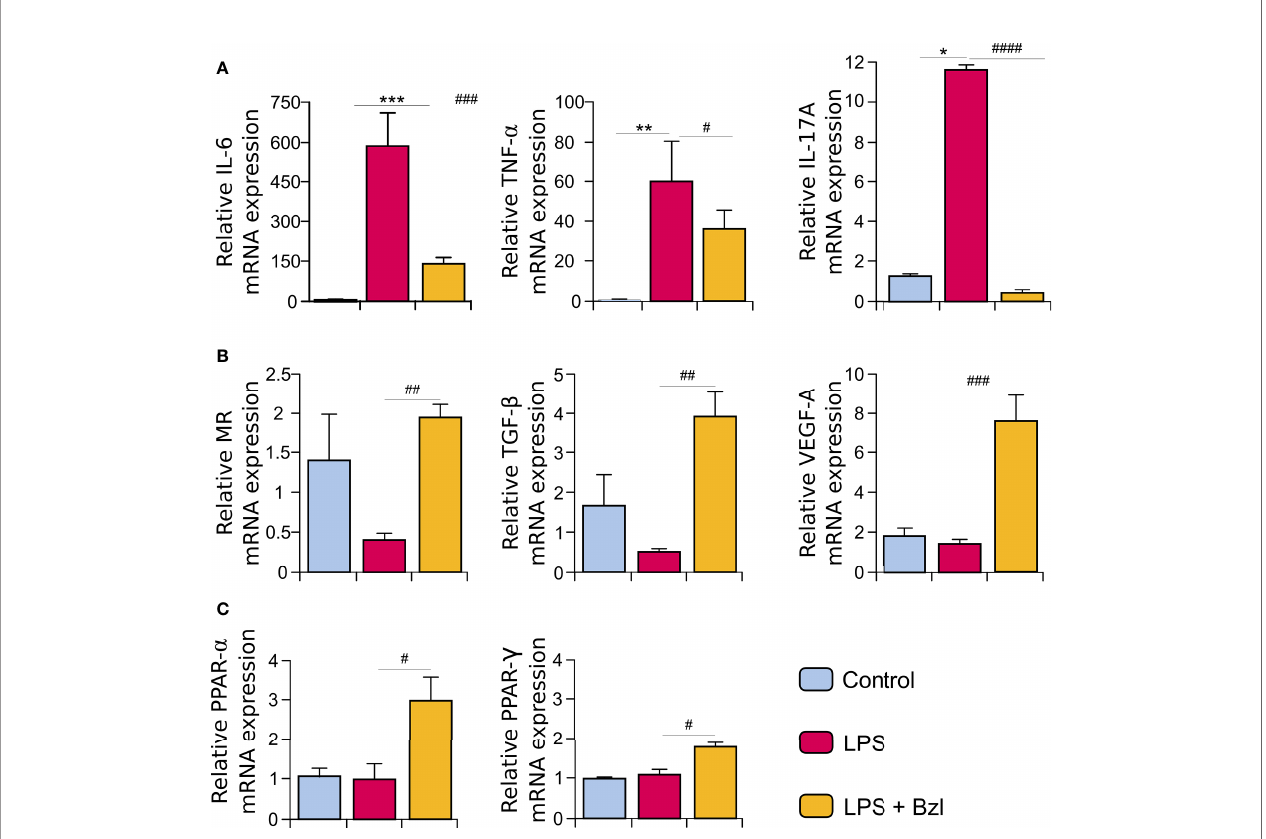
FIGURE 5 | RAW 264.7 macrophages were treated with 15 µM of benznidazole (Bzl) for 30 minutes and then with 10 µg/mL of LPS. After 4 h, IL-6, TNF- a and IL- 17A mRNA levels were analyzed by RT-qPCR and normalized against b -actin mRNA (A) . After 24 h, Mannose Receptor (MR), TGF- b , VEGF-A (B) , PPAR- a and PPAR- g (C) mRNA levels were analyzed by RT-qPCR and normalized against b -actin mRNA. Results are expressed as the mean of 3 independent experiments (n=3, 5 replicates/treatment) ± SEM. * P < 0.05, **P < 0.001, ***P < 0.0001 vs. control cells; # P < 0.05, ## P < 0.001, ### P < 0.0001, #### P < 0.00001 vs LPS- stimulated